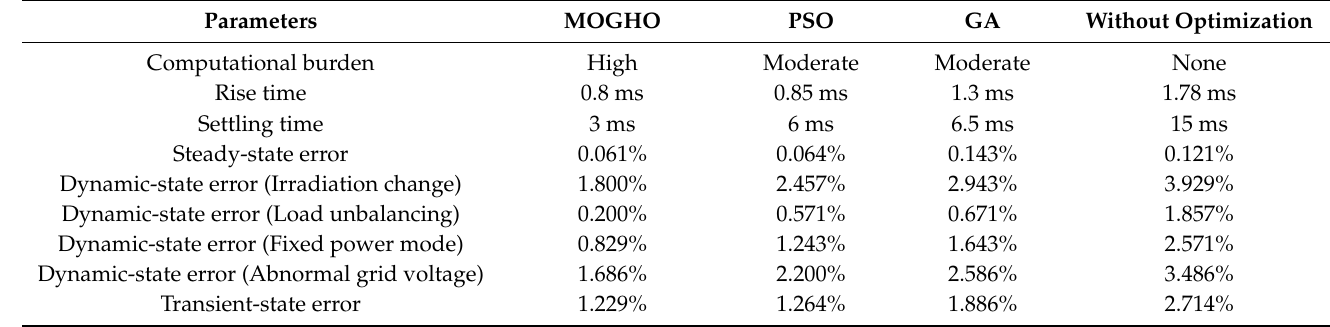
Table 3. Comparative performance of DC bus.